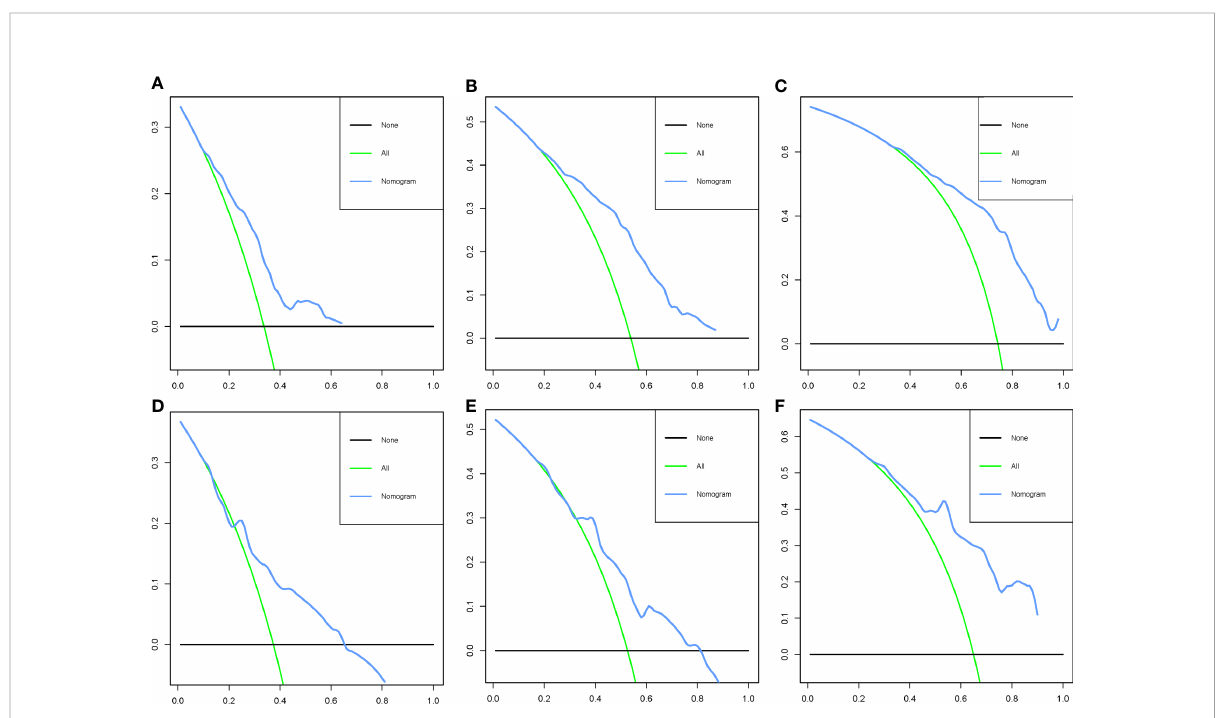
FIGURE 4 Decision curve analysis of the nomogram in the training cohort (A – C) and the validation cohort (D – F)